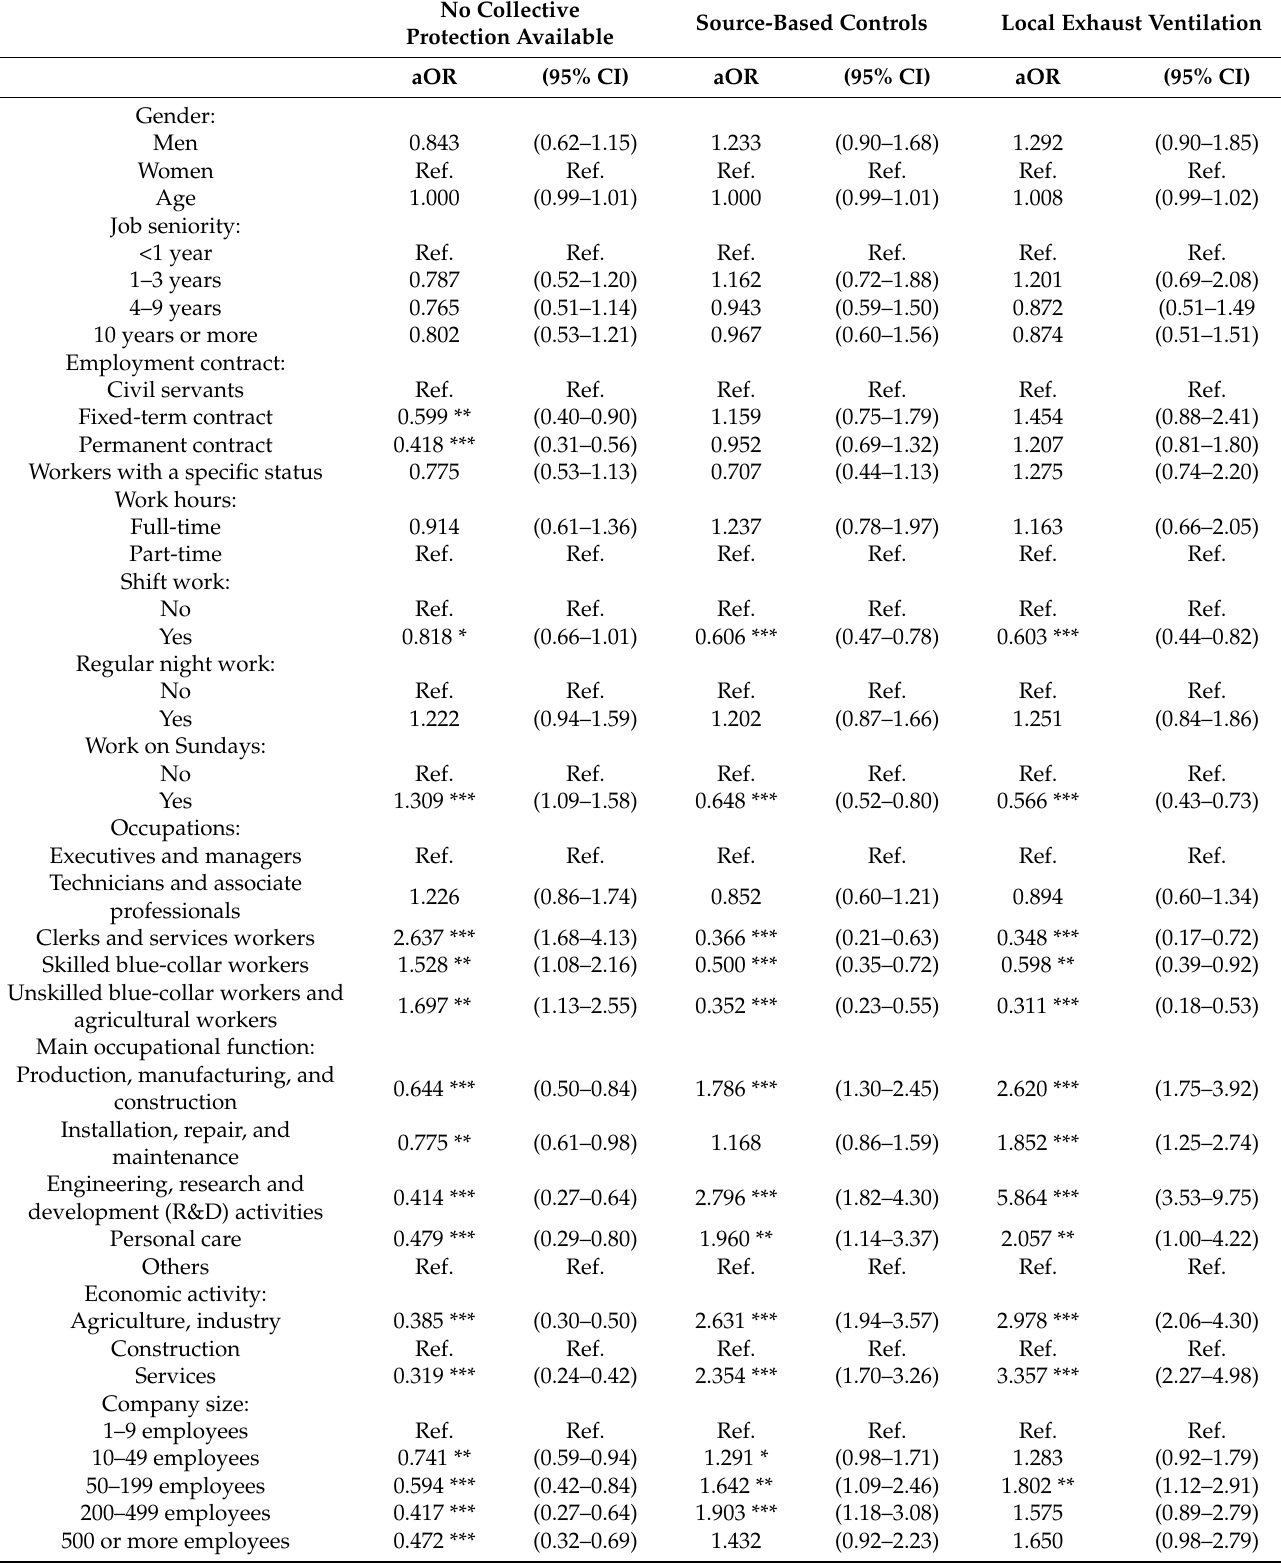
Table 3. Results of multivariate logistic regressions for different measures of collective